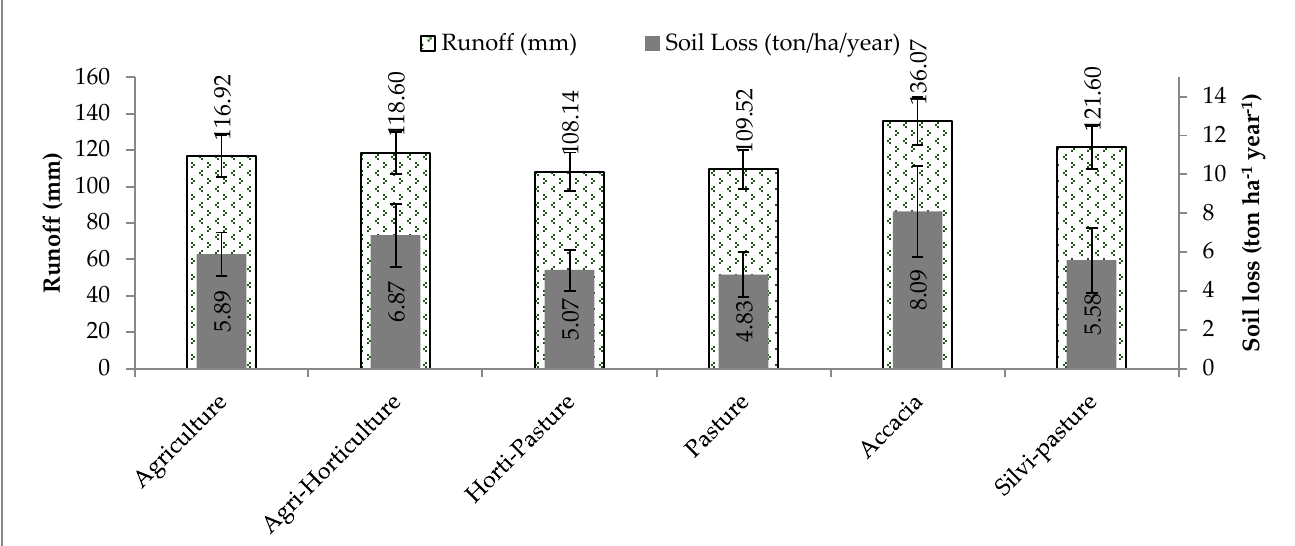
Figure 7. Average runoff (mm) and soil loss (ton ha − 1 year − 1 ) under selected land use systems over the period of 9 years of experiment (2011–2019). The error bar denotes ±1 SE. T 1 —Agriculture, Glycin